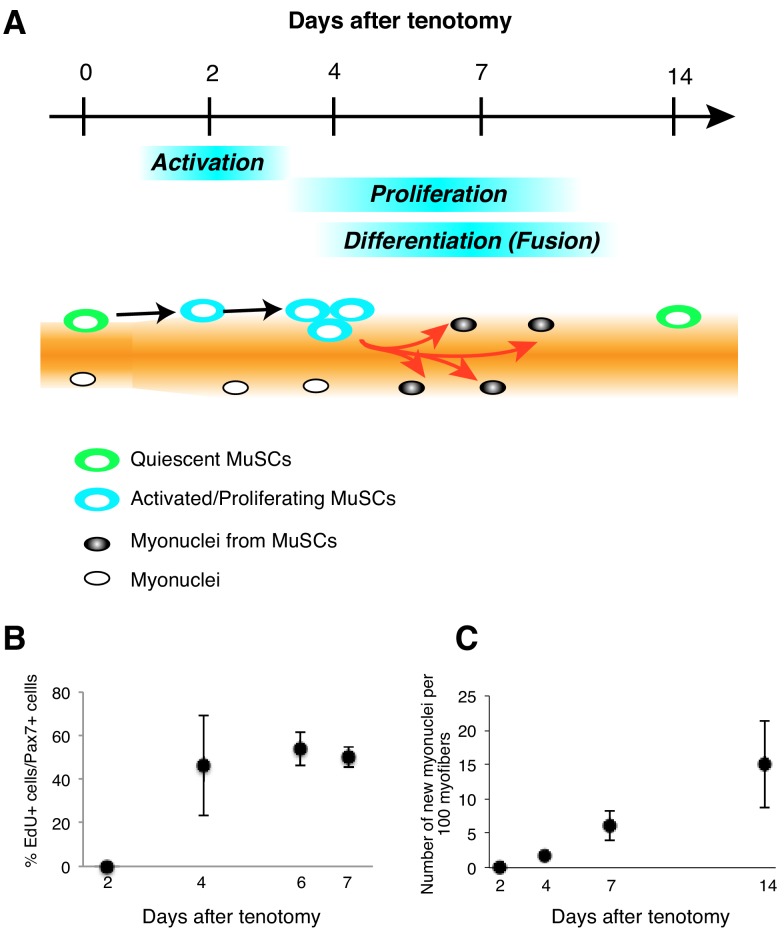
Kinetics of MuSC behavior in overloaded muscle.(A) MuSC behavior in overloaded muscle. (B) Frequency of EdU+Pax7+ cells among Pax7+ cells. After tenotomy, EdU was injected until mice were sacrificed. (C) Gradual increases in the number of new MuSC-derived myonuclei up to 14 days after tenotomy. After tenotomy, EdU was injected until mice were sacrificed.10.7554/eLife.48284.027Figure 7—figure supplement 1—source data 1.Raw data in Figure 7—figure supplement 1.